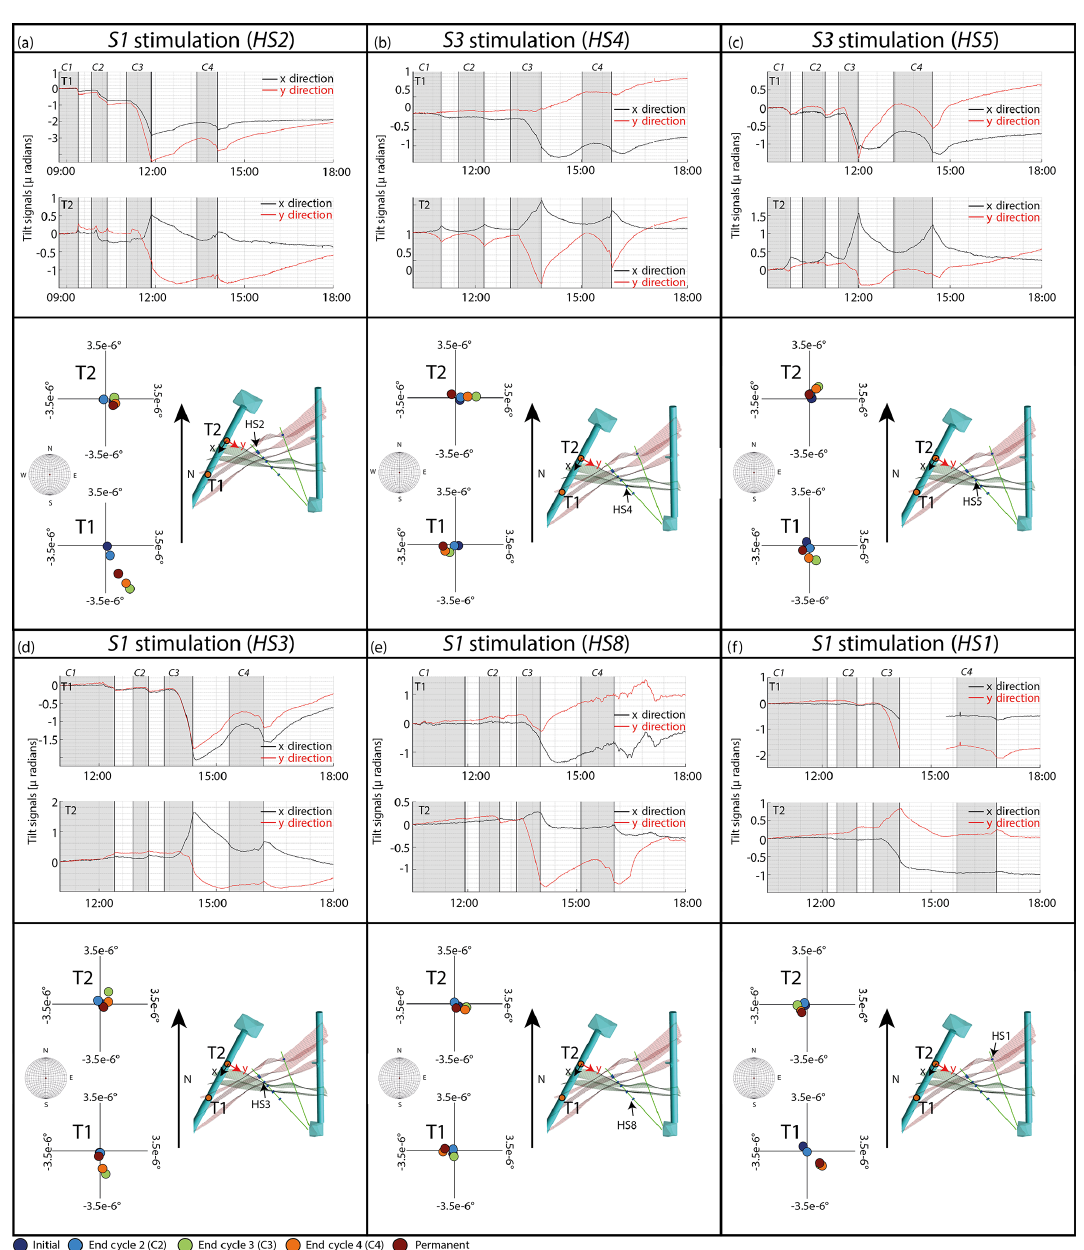
Figure A9. Inclinometer data for each of the six experiments. The upper part of each panel shows the tilt time series for both experiments with the injection periods marked by the shaded vertical bands. The lower part of each panel shows a horizontal section through the study volume at the level of the tunnels, showing the shear zones and tiltmeter T1 and T2 positions. The x and y axes of the tilt data are indicated on T2. Changes in the downward-oriented normal vector of the tunnel floor at T1 and T2 are shown in the lower hemisphere plots at the left of the